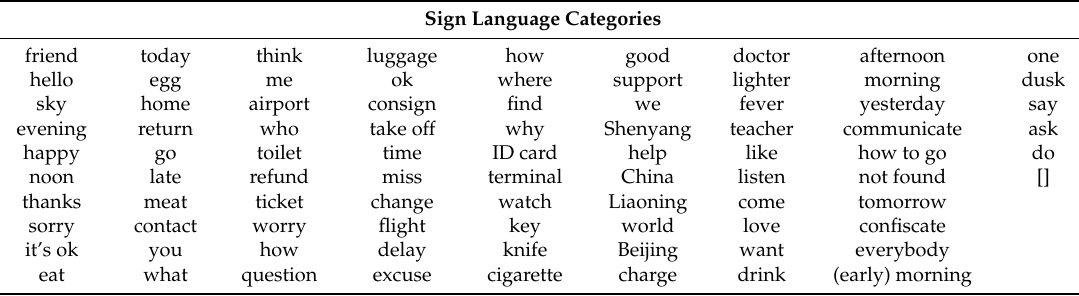
Table 1. List of sign language categories. “[]” stands for “empty” class. Sign Language